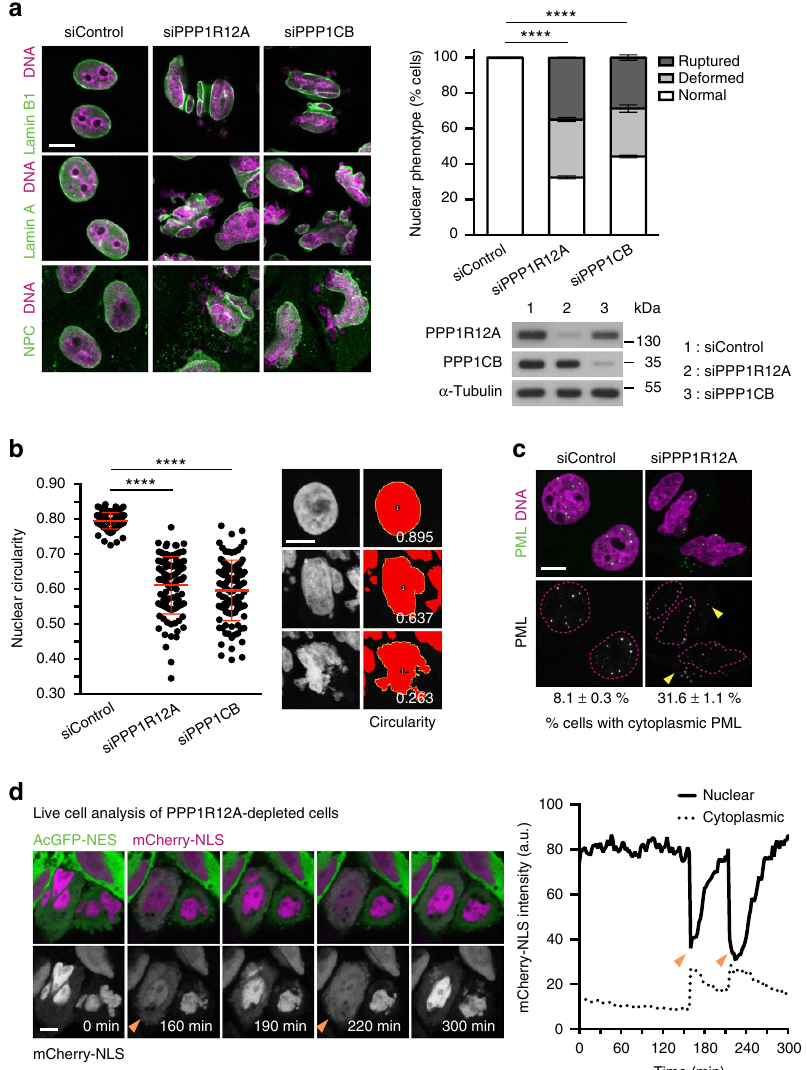
Figure 1 | Depletion of PPP1R12A and PPP1CB causes nuclear deformation and nuclear envelope rupture. ( a – c ) HeLa Kyoto cells transfected with PPP1R12A or PPP1CB siRNA were fixed 56h after transfection. ( a ) Cells were stained with the indicated nuclear envelope markers and DAPI (left panel). Quantification of phenotype (top right panel). Immunoblot analysis of siRNA-transfected cells (bottom right panel). Abnormal nuclear shape (deformed) and nuclear envelope discontinuity (ruptured) are quantified. Error bars, s.d. of three independent experiments ( n 4 200 cells each). ( b ) PPP1R12A and PPP1CB siRNA-transfected cells were stained with DAPI and nuclear circularity was calculated for each nucleus (left panel). Red bars show mean and s.d. of three experiments. Representative nuclear shapes and their circularity indices are shown (right panel). Error bars, s.d. of three independent experiments ( n 4 100 nuclei each). ( c ) Localization of PML in PPP1R12A-depleted cells was analysed by immunofluorescence staining. The filled arrowheads indicate cytoplasmic PML signals. Percentages obtained from three independent experiments ( n 4 200 cells each). Mean of three experiments ± s.e.m. is shown. ( d ) Time-lapse microscopy of PPP1R12A-siRNA-transfected HeLa Kyoto cells transiently expressing AcGFP-NES and mCherry-NLS (left panel). Recording was started 40h after transfection (0min). mCherry-NLS signal intensity in the nucleus and cytoplasm was quantified over time (right panel). The filled arrowheads indicate nuclear rupture events characterized by the sudden efflux of mCherry-NLS from the nucleus into the cytoplasm. Graphs in a , b show **** P o 0.0001 ( a w 2 test, b one-way ANOVA Tukey’s multiple comparison test). Scale bars, 10 m